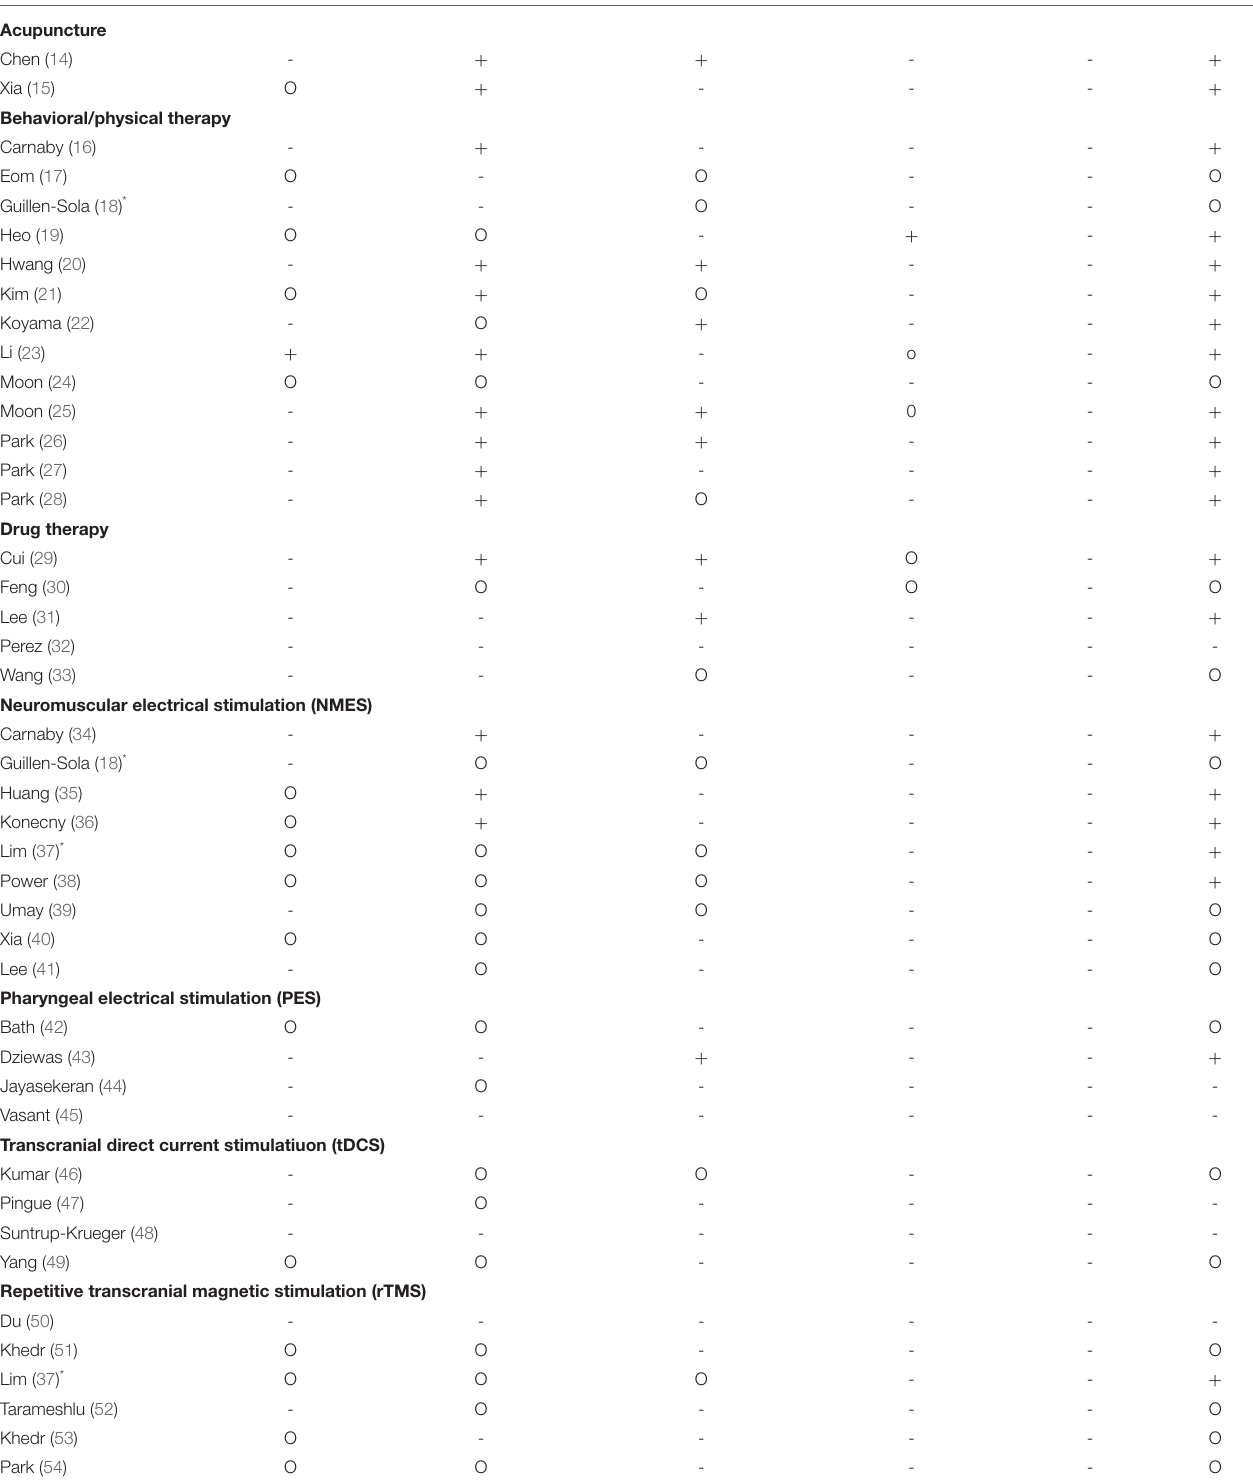
TABLE 2 | Summary of risk of bias assessment. Risk of bias